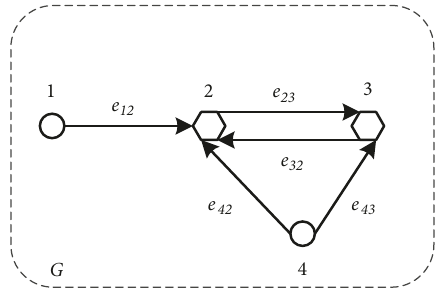
Figure 1: A subgraph of shareholding